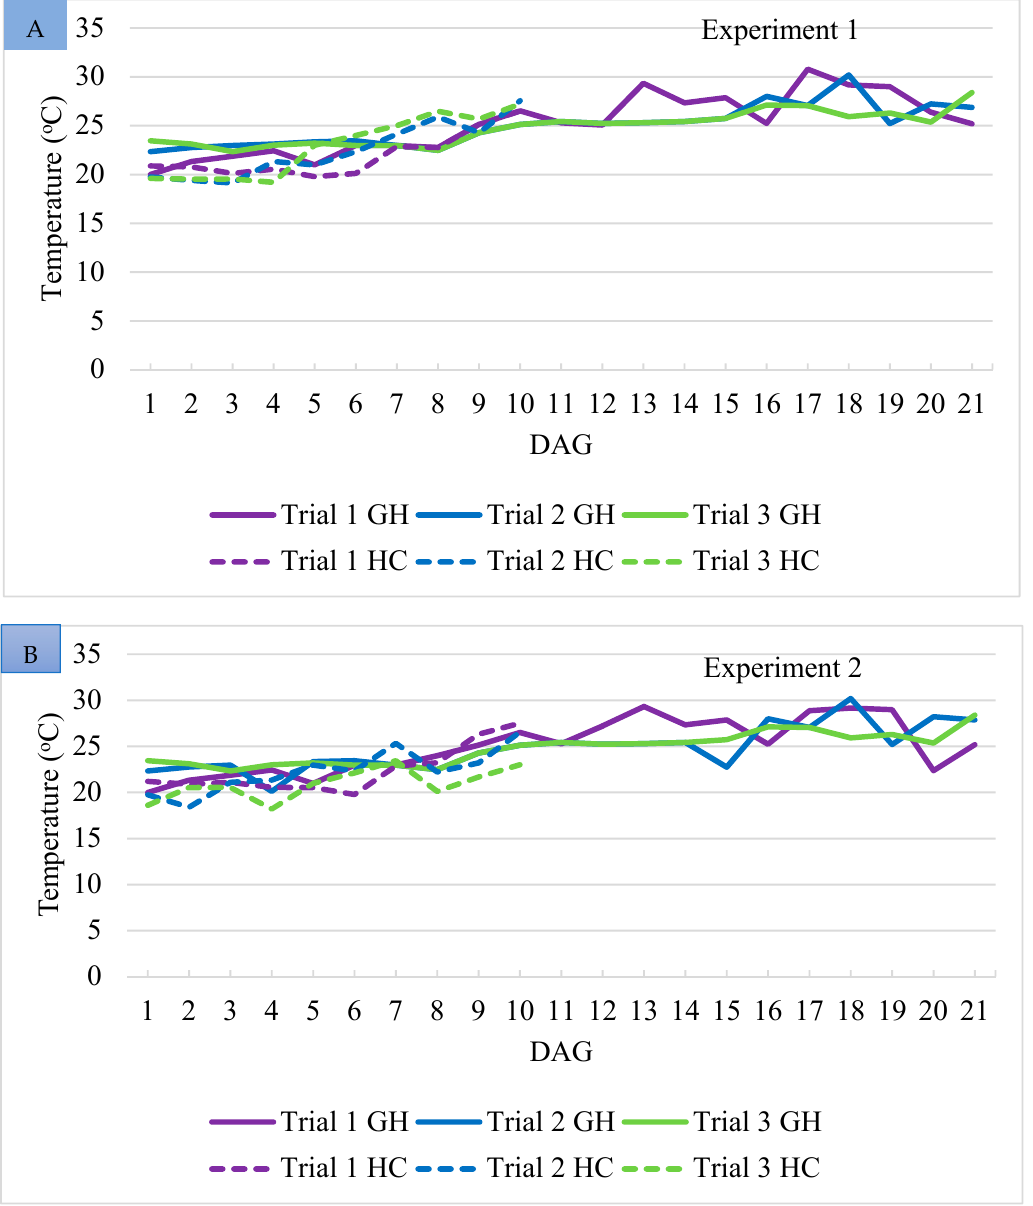
Figure 1. Temperature (°C) in the healing chamber (HC) for 10 days after grafting (DAG) and in the greenhouse (GH) for 21 DAG for trials 1, 2, and 3 on 5 March, 15 March, and 23 April 2020, respectively, for experiment 1 ( A ), and for trials 1, 2, and 3 on 19 August, 14 October, and 10 November, 2020, respectively, for experiment 2 ( B ) at Mount Vernon, WA, USA. Data were recorded every 15 min (Onset HOBO, Bourne, MA, USA).